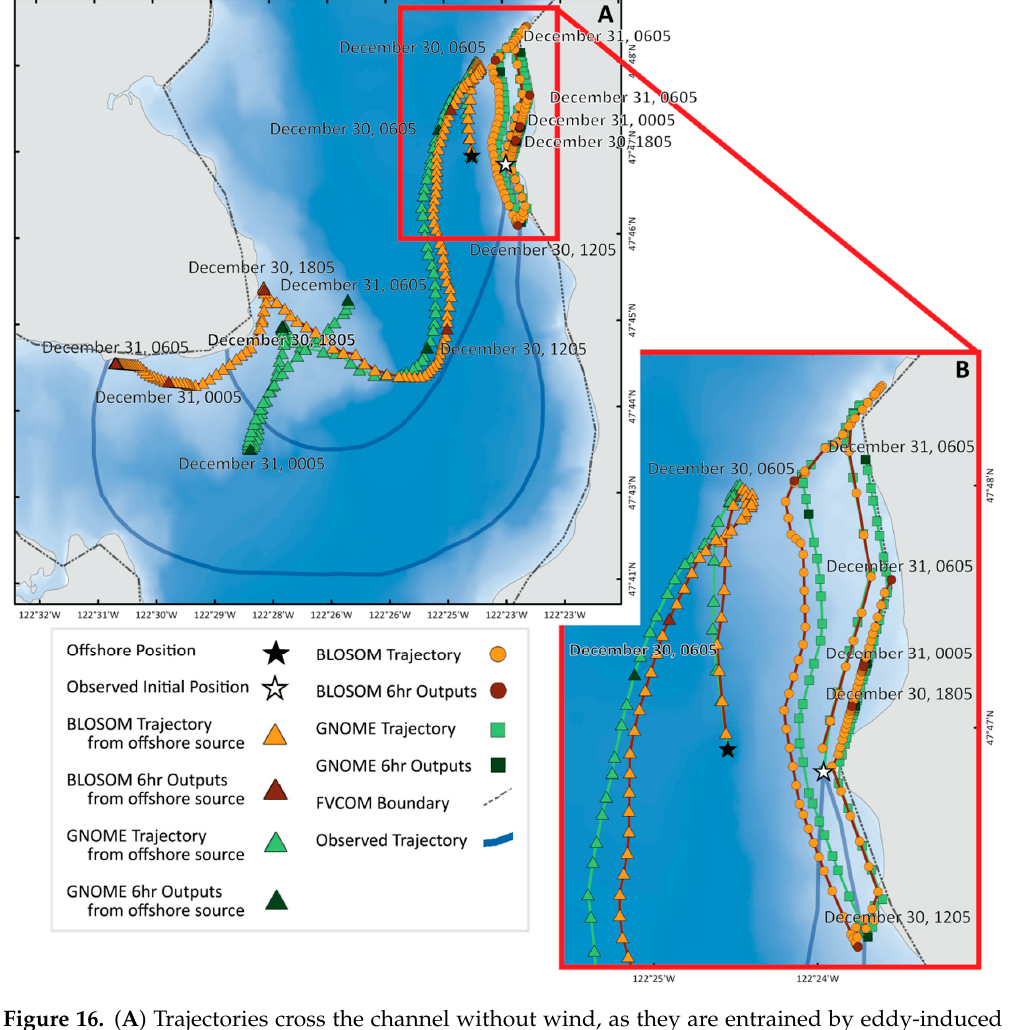
Figure 16. ( A ) Trajectories cross the channel without wind, as they are entrained by eddy-induced cross-channel transport when initiated offshore from the location of the oil spill; test 6. ( B ) Zoomed in view of the simulations that were initiated at the correct oil spill location.